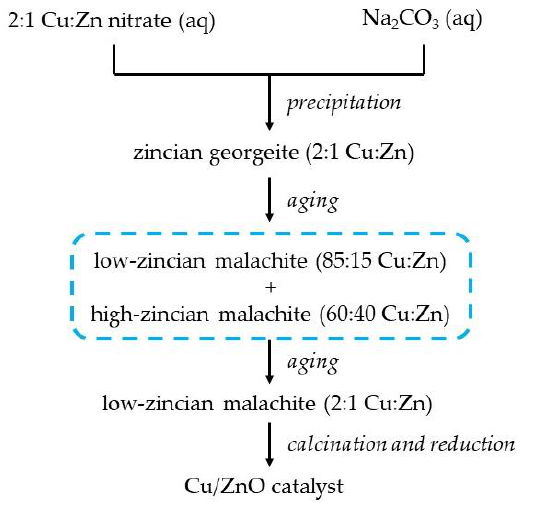
Figure 3. Flow Jdiagram for the precipitation preparation of Cu/ZnO catalysts [79].